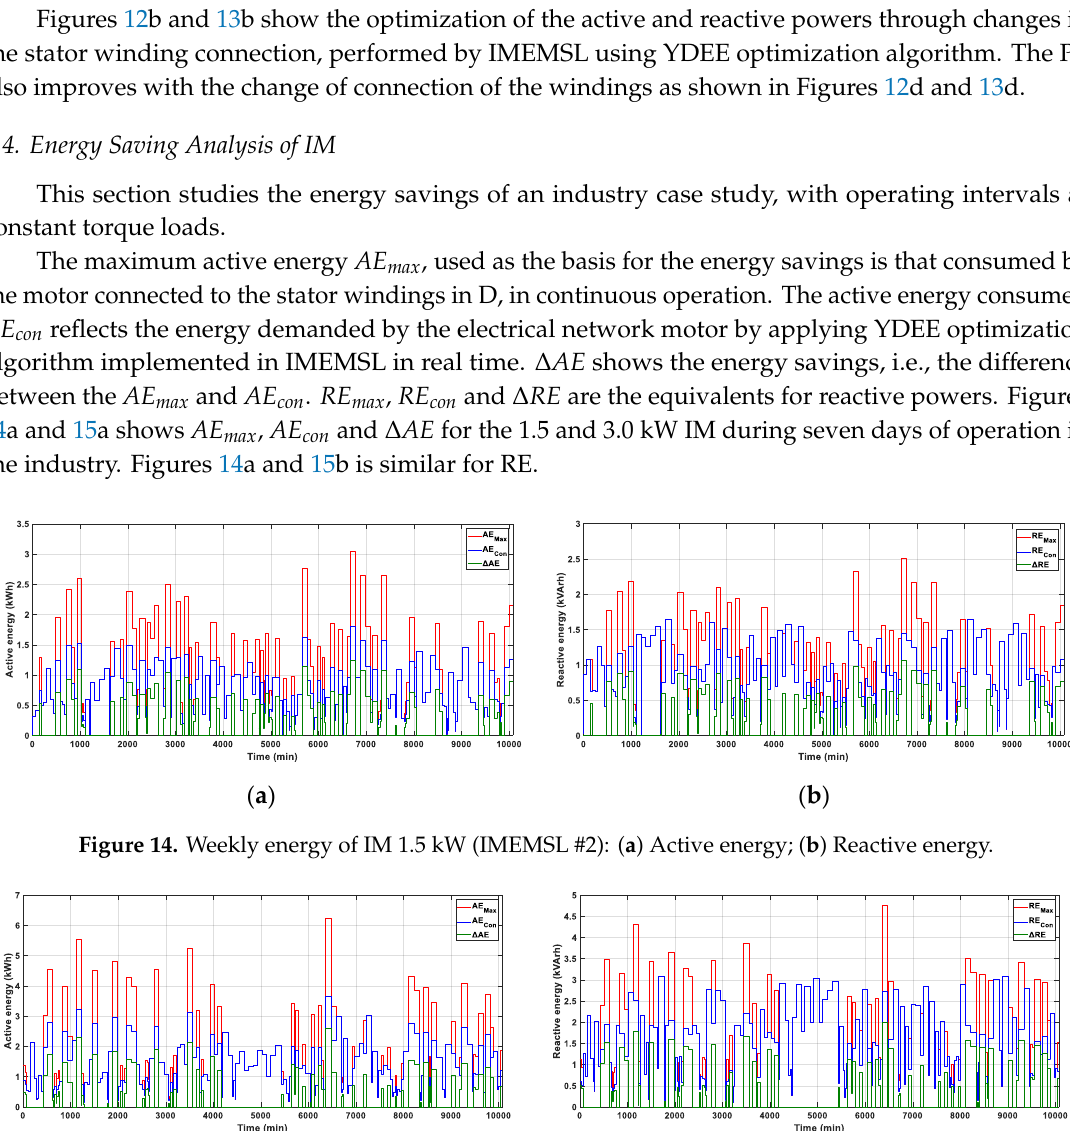
Figure 13. Weekly study of IM 2.2 kW (IMEMSL #3): ( a ) Energy efficiency; ( b ) Active and reactive power; ( c ) Load factor; ( d ) Power factor.